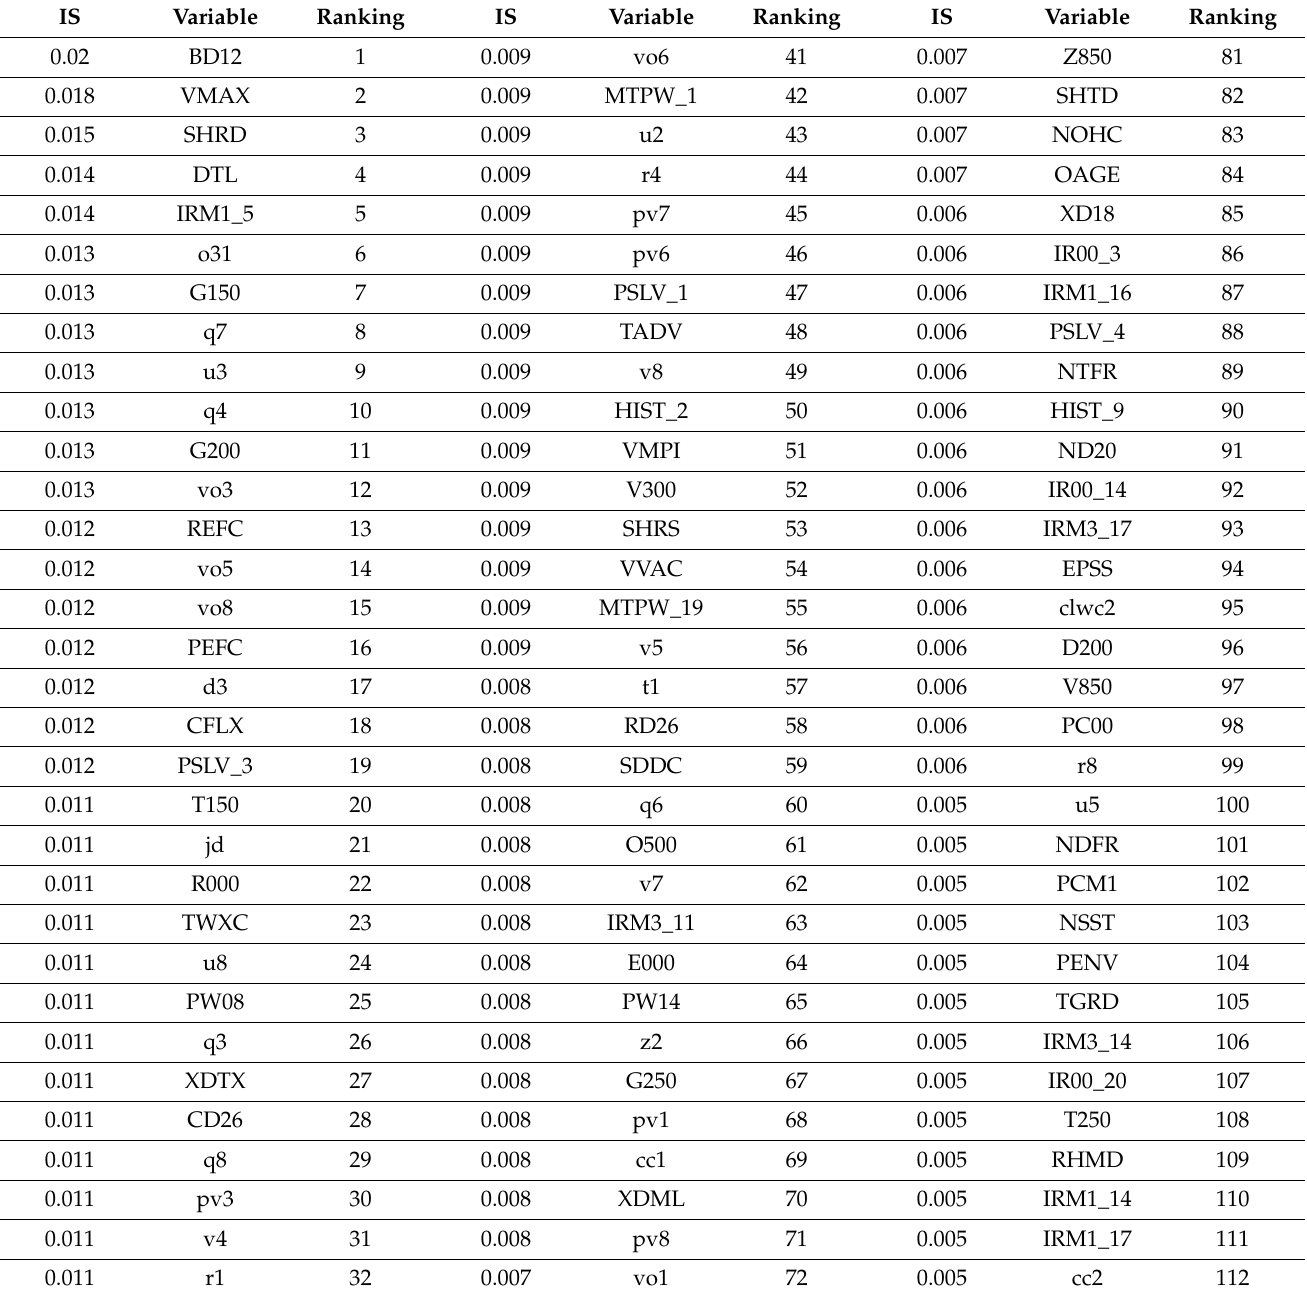
Table A1. The importance scores of all of the 120